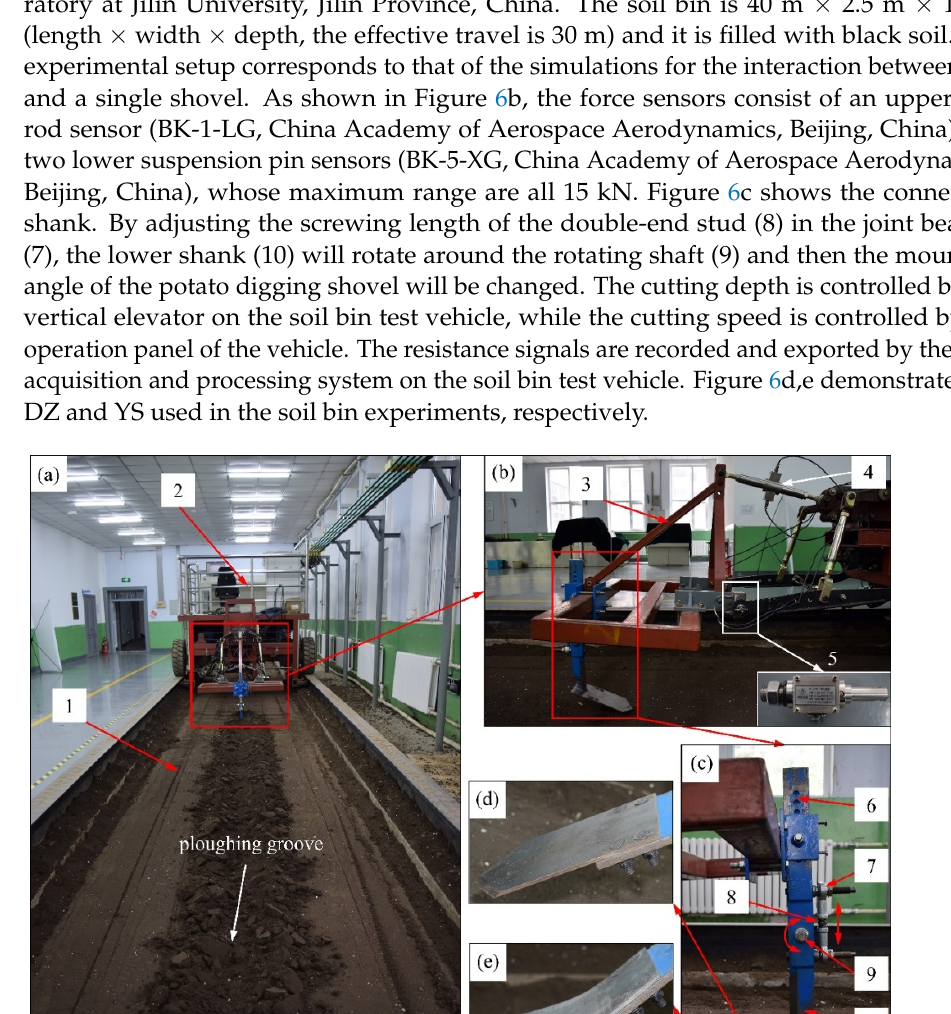
Table 2. Factors and levels used in the simulations based on Box–Behnken RSM. Factor